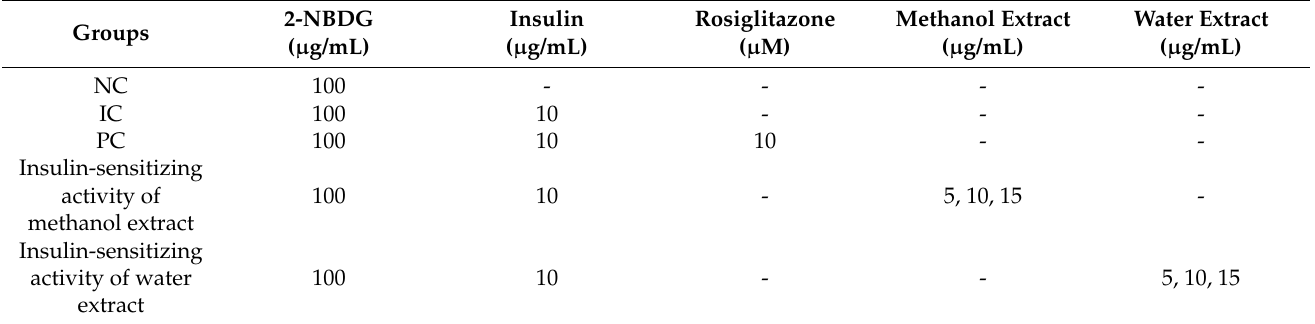
Table 7. 2-NBDG treatment